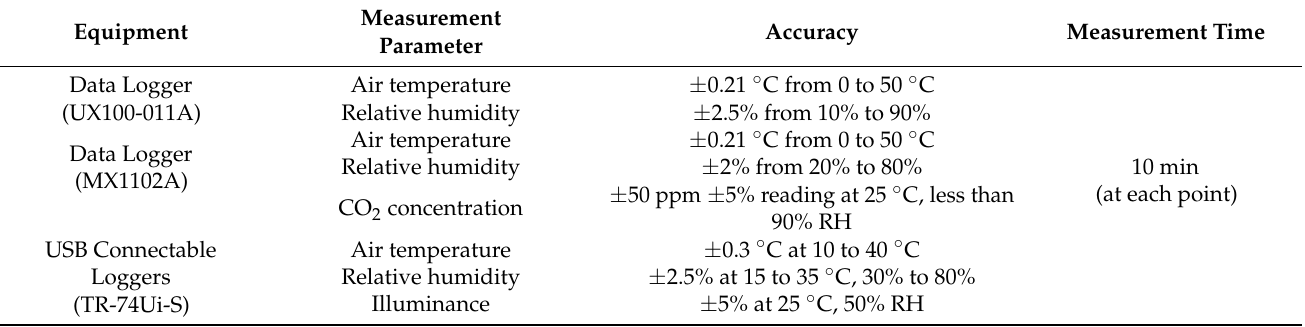
Table 2. Information on measurement